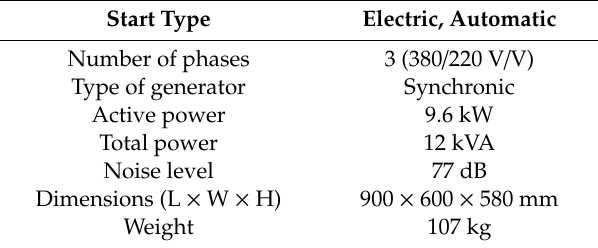
Table 2. Main specifications of the generator